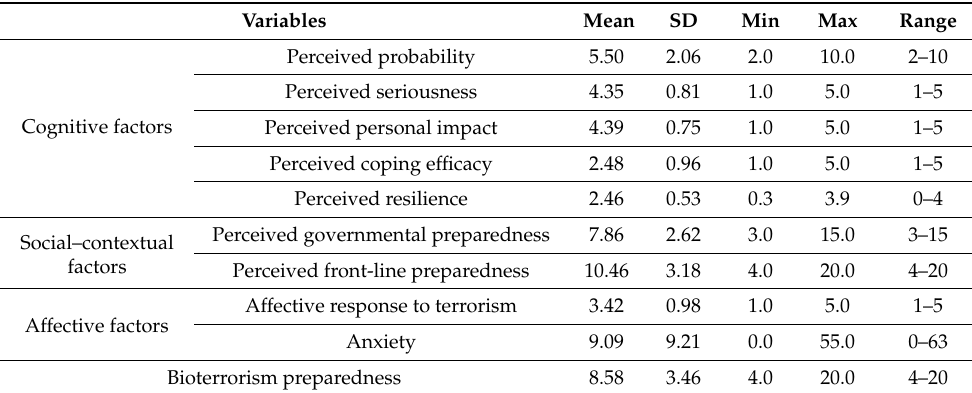
Table 2. The level of study variables ( N = 1050).